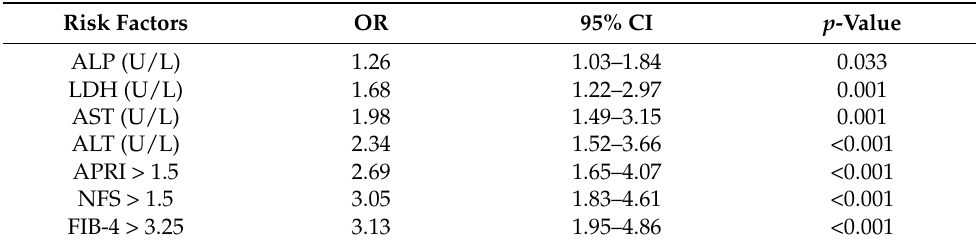
Table 6. Associations between significant liver markers and fibrosis scores at admission with mortality in the elderly patients with